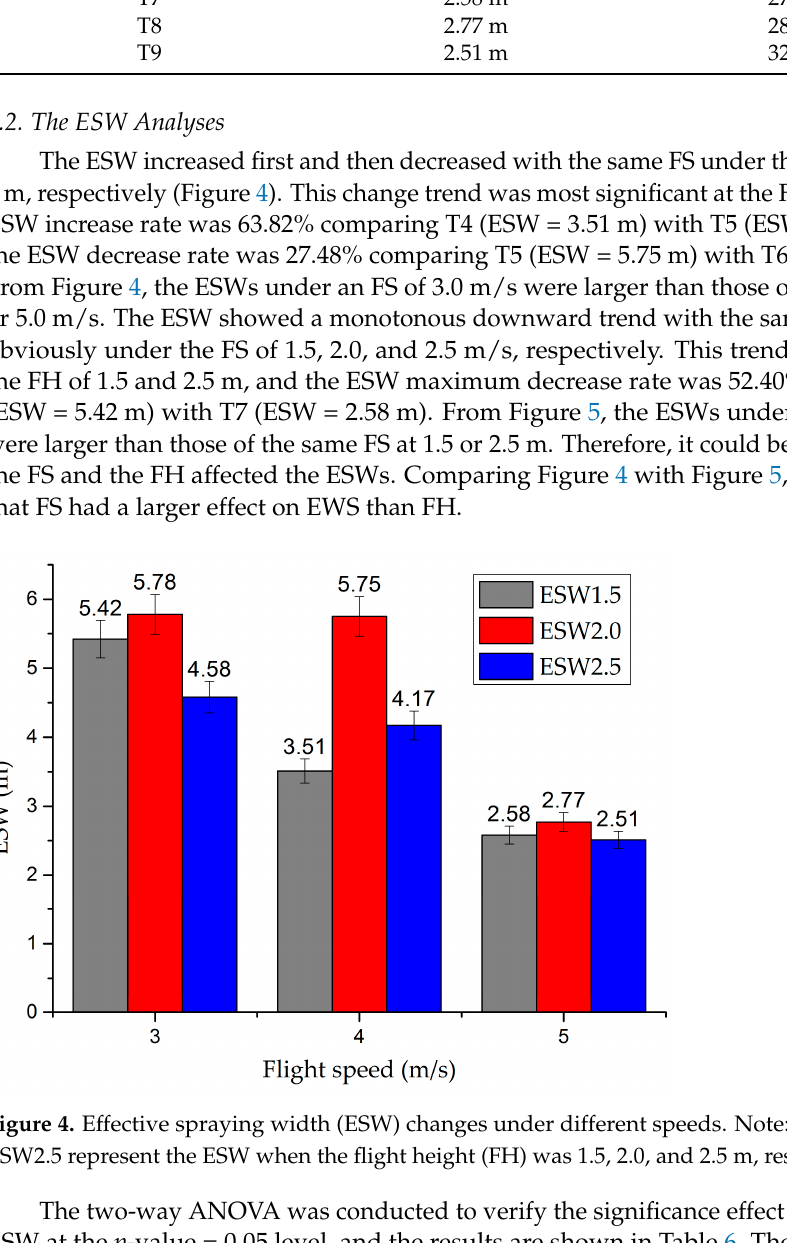
Figure 5. ESW changes under different heights. Note: ESW3, ESW4, and ESW5 represent the ESW when the flight speeds (FS) were 3.0, 4.0 m/s, and 5.0 m/s, respectively. The two-way ANOVA was conducted to verify the significance effect of FS and FH on ESW at the p -value = 0.05 level, and the results are shown in Table 6. The FS has a highly significant impact on ESW ( p = 0.0033 < 0.01), the FH has no significant impact on the ESW ( p = 0.136 ＞ 0.05), and the interaction between FS and FH also has no signifi- cant impact on ESW ( p = 0.906 > 0.05).